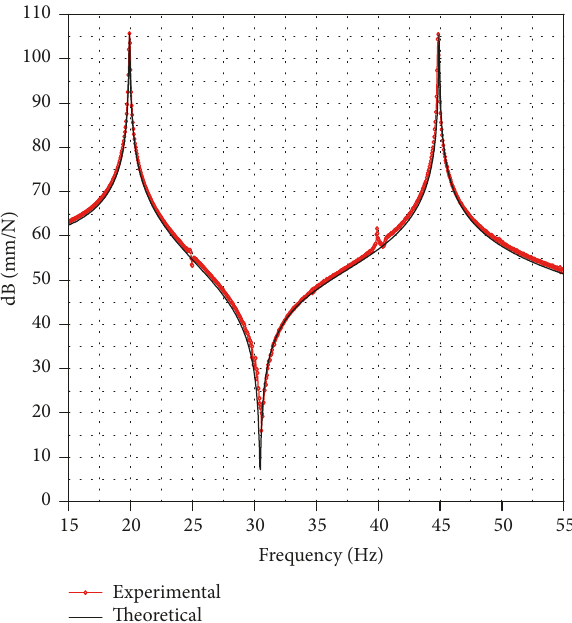
Figure 10: Comparison of theoretical and experimental results for only plate.